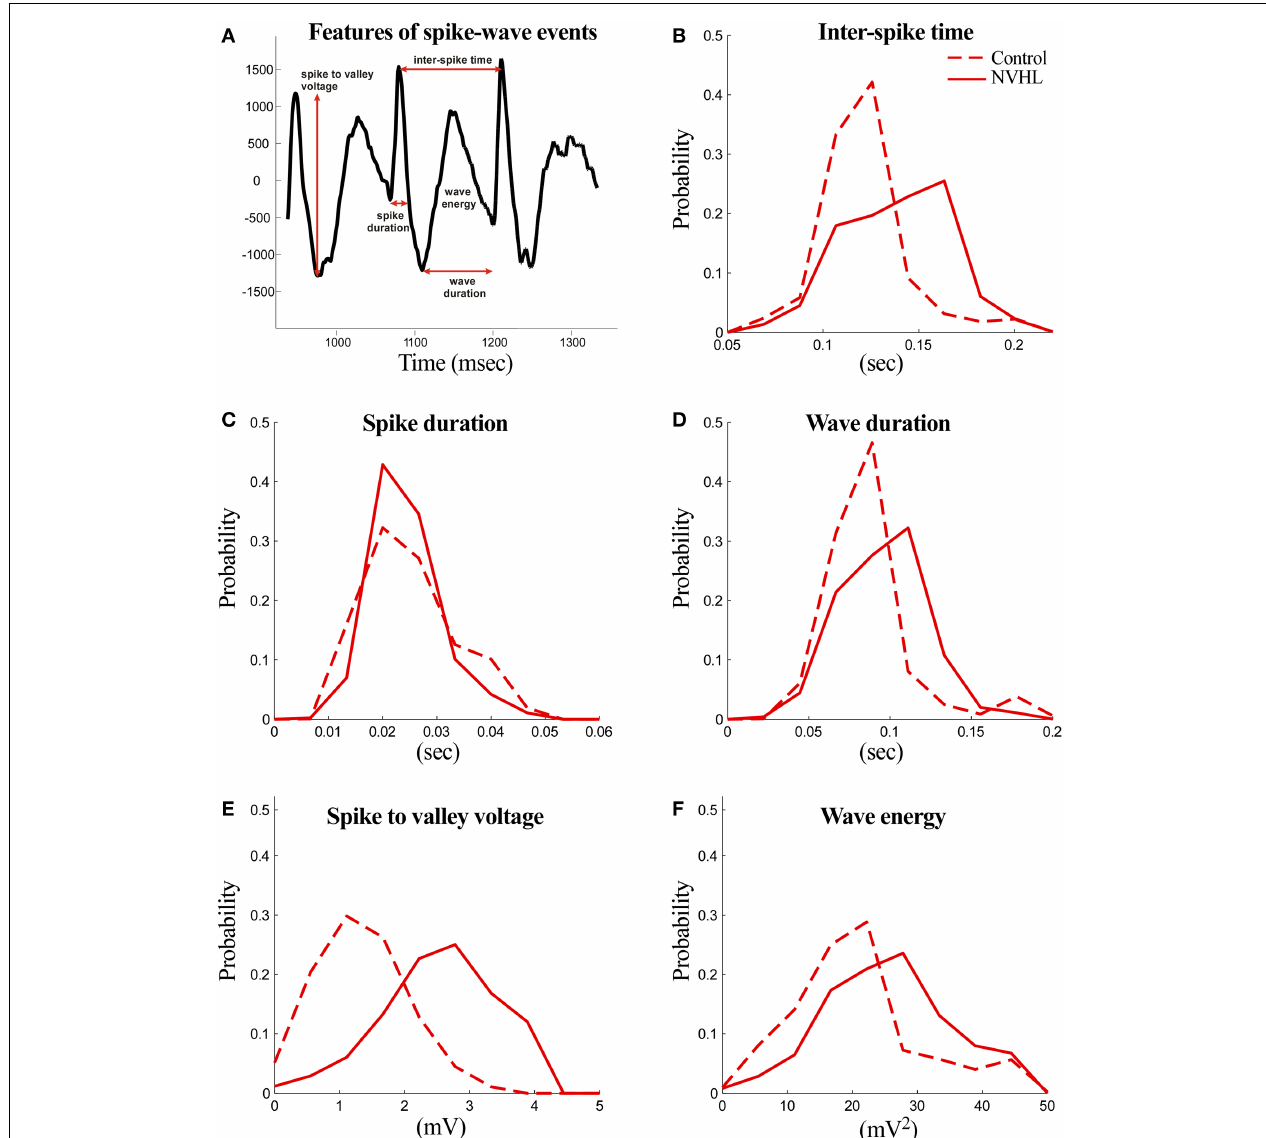
FIGURE 3 |Abnormal features of the spike-wave activities in NVHL rats . (A) Three spike-wave cycles are shown to illustrate the features that were measured.The analyzed features include spike duration, inter-spike time, wave duration, spike-to-valley voltage, and inter-spike time. Comparison of the spike-wave complex features in NVHL and control rats: (B) inter-spike time,